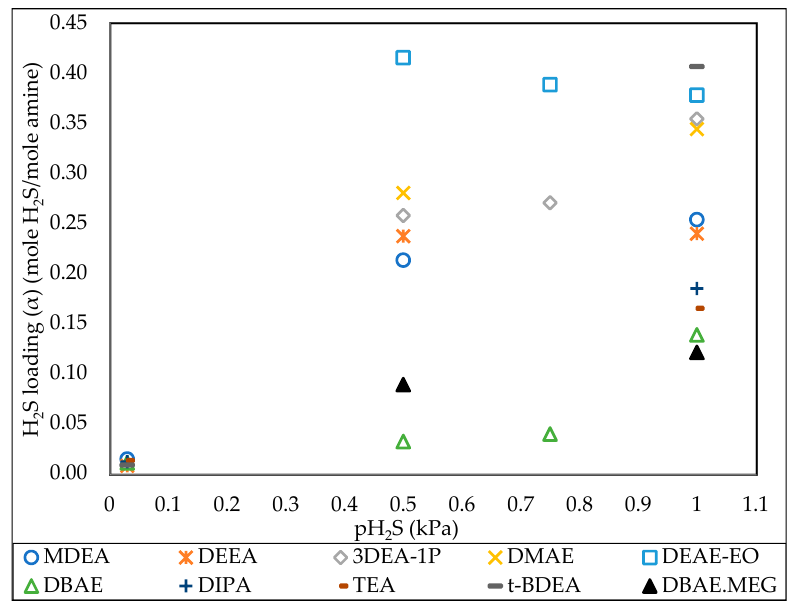
Figure 7. Effect of inlet H 2 S partial pressure on H 2 S loading; T = 5 °C ± 0.1 °C; amine concentration = 20 wt.% (unloaded); DBAE solutions makes two phases.